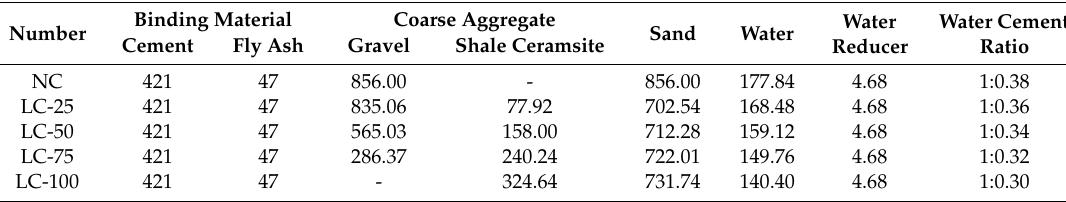
Table 3. Performances of different types of concrete.